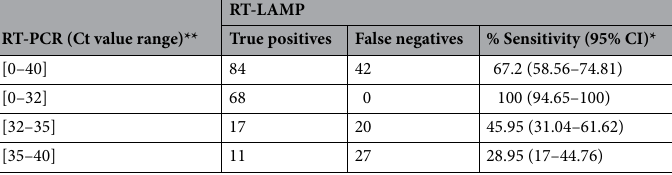
Table 1. RT-LAMP sensitivity across different ranges of Ct values. *Wilson’s binominal confidence interval. **Ct values rounded to the nearest unit.